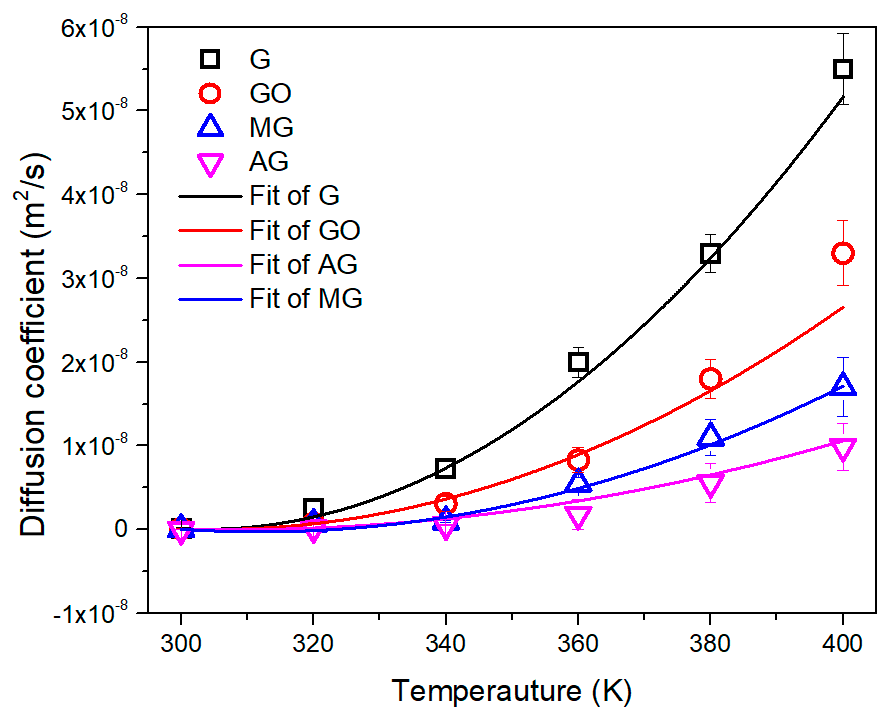
Figure 9. Diffusion coefficients of graphene containing two functional groups with respect to increasing temperature at 0.1 MPa.